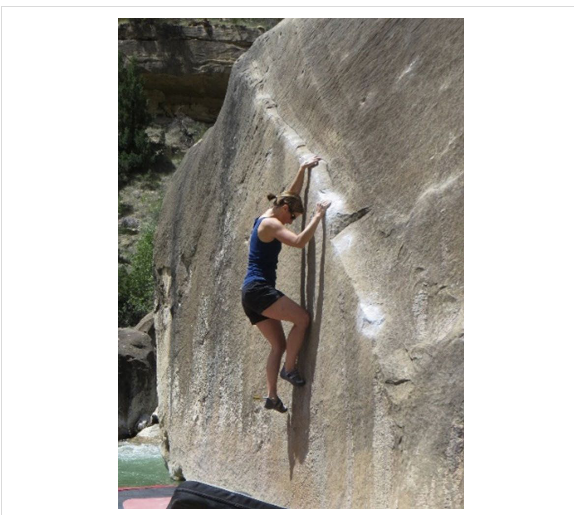
Figure 6: The author intensely focused on climbing the boulder problem “The Angler” during a research group outing to Joe’s Valley, UT. Photo credit: Zhesen